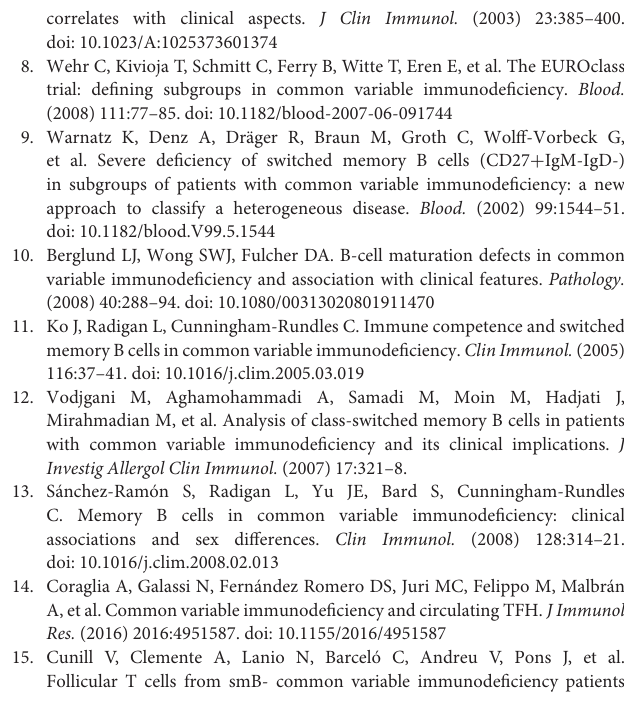
Supplementary Figure 1 | Immunophenotyping gating strategies. Flow cytometry plots showing the gating strategy employed to differentiate and quantify each of the 54 cell parameters. Plots are pre-gated on live cells or lymphocytes (as indicated) after removal of doublets. Four antibody FACS panels were used covering T cells (A,B) , B cells (C) , and myeloid/NK cells (D) . Cell populations are named on final gate. Markers used to define each gate are indicated. Arrows between plots indicate sub-gating. Supplementary Figure 2 | Correlation between values derived from 3 different transitional gating strategies (see section Methods). Scatter plots show the correlation between the frequency of transitional B cell populations in all analyzed patients and controls, as defined by either CD38 + /CD24 + B cells (“Trans-b”) as the independent variable, in comparison to CD38 + /CD10 + B cells (“Trans-a”) or CD38 + /IgM-hi B cells (“Trans-c”). Supplementary Figure 3 | T cell memory subpopulation gating demonstrating CD45RA over-expression in an individual bearing the variant PTPRC G77 allele (bottom) compared to an individual with the wild type allele (top). Gating on CD4 (left) or CD8T cells (right). Supplementary Figure 4 | Coefficients of Variation (CV) for all 54 FCM parameters. Values above 30% were considered to show significant imprecision and are shaded. Supplementary Table 1 | Details of the PID patients in the four cohorts analyzed in the cited figures. Supplementary Table 2 | Reagents used for staining cells for flow cytometry, for the four separate panels. Supplementary Table 3 | Raw percentages and derived centiles for each of the FCM parameters from subjects whose corresponding heatmaps are presented in Figures 4 – 6 (Cent. =